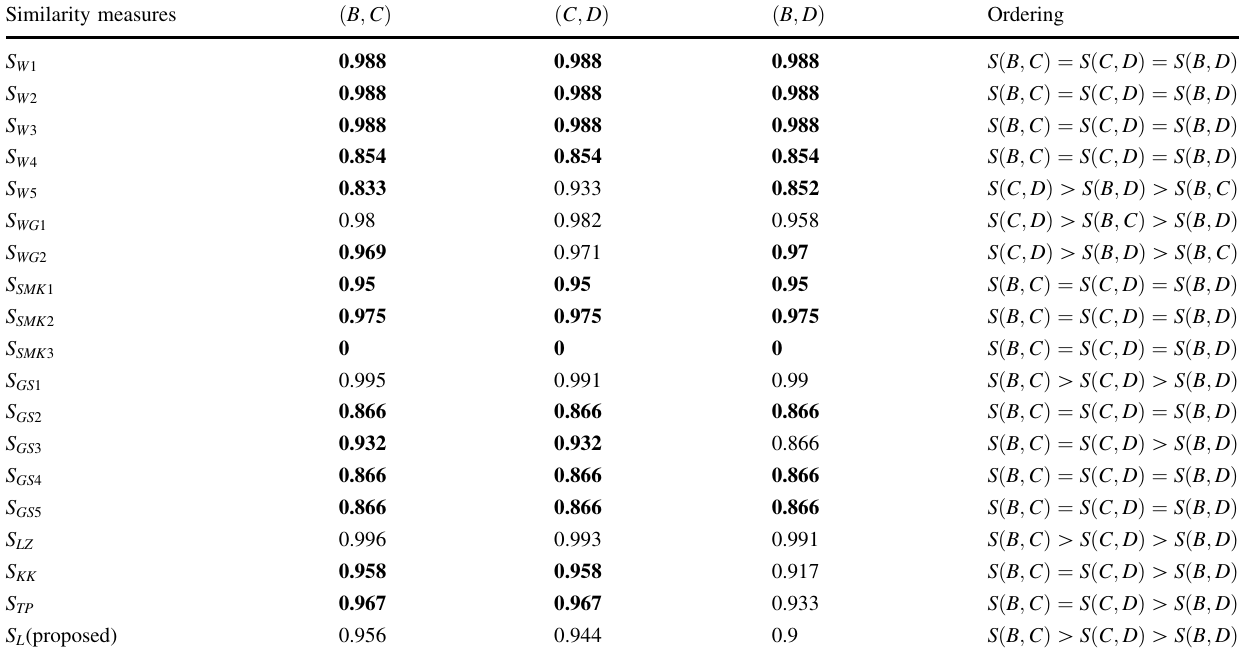
Table 2 Comparison results of PF similarity measure Similarity measures